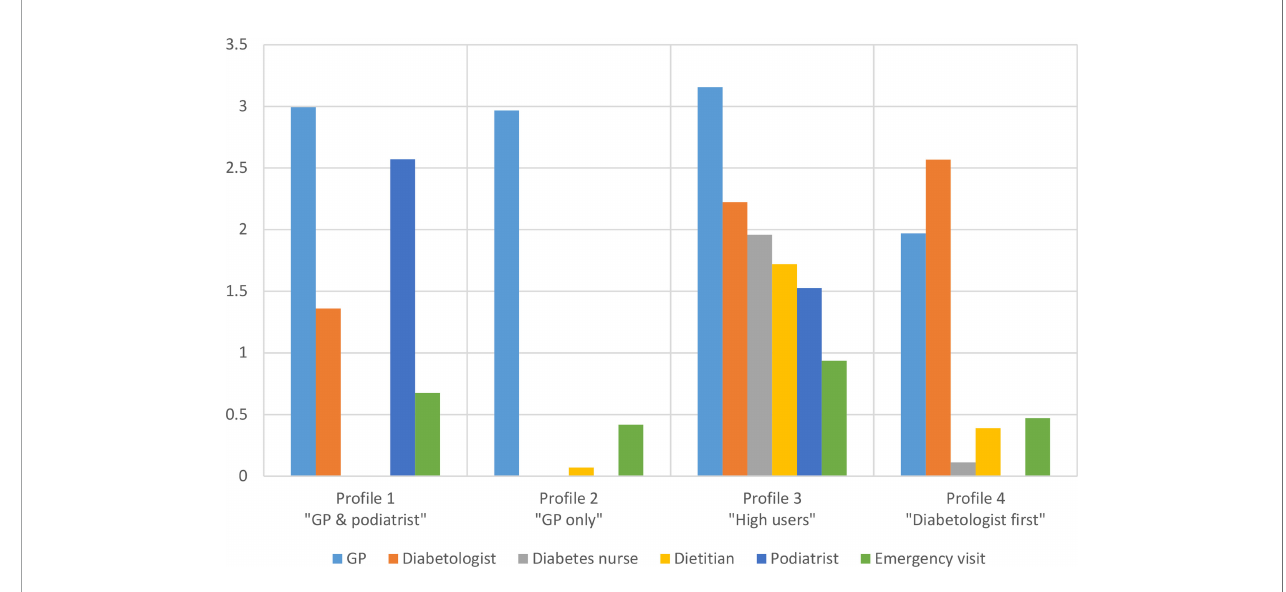
FIGURE 1 | Mean number of visits in the past 12 months, by provider and healthcare use pro fi le. GP, general practitioner.